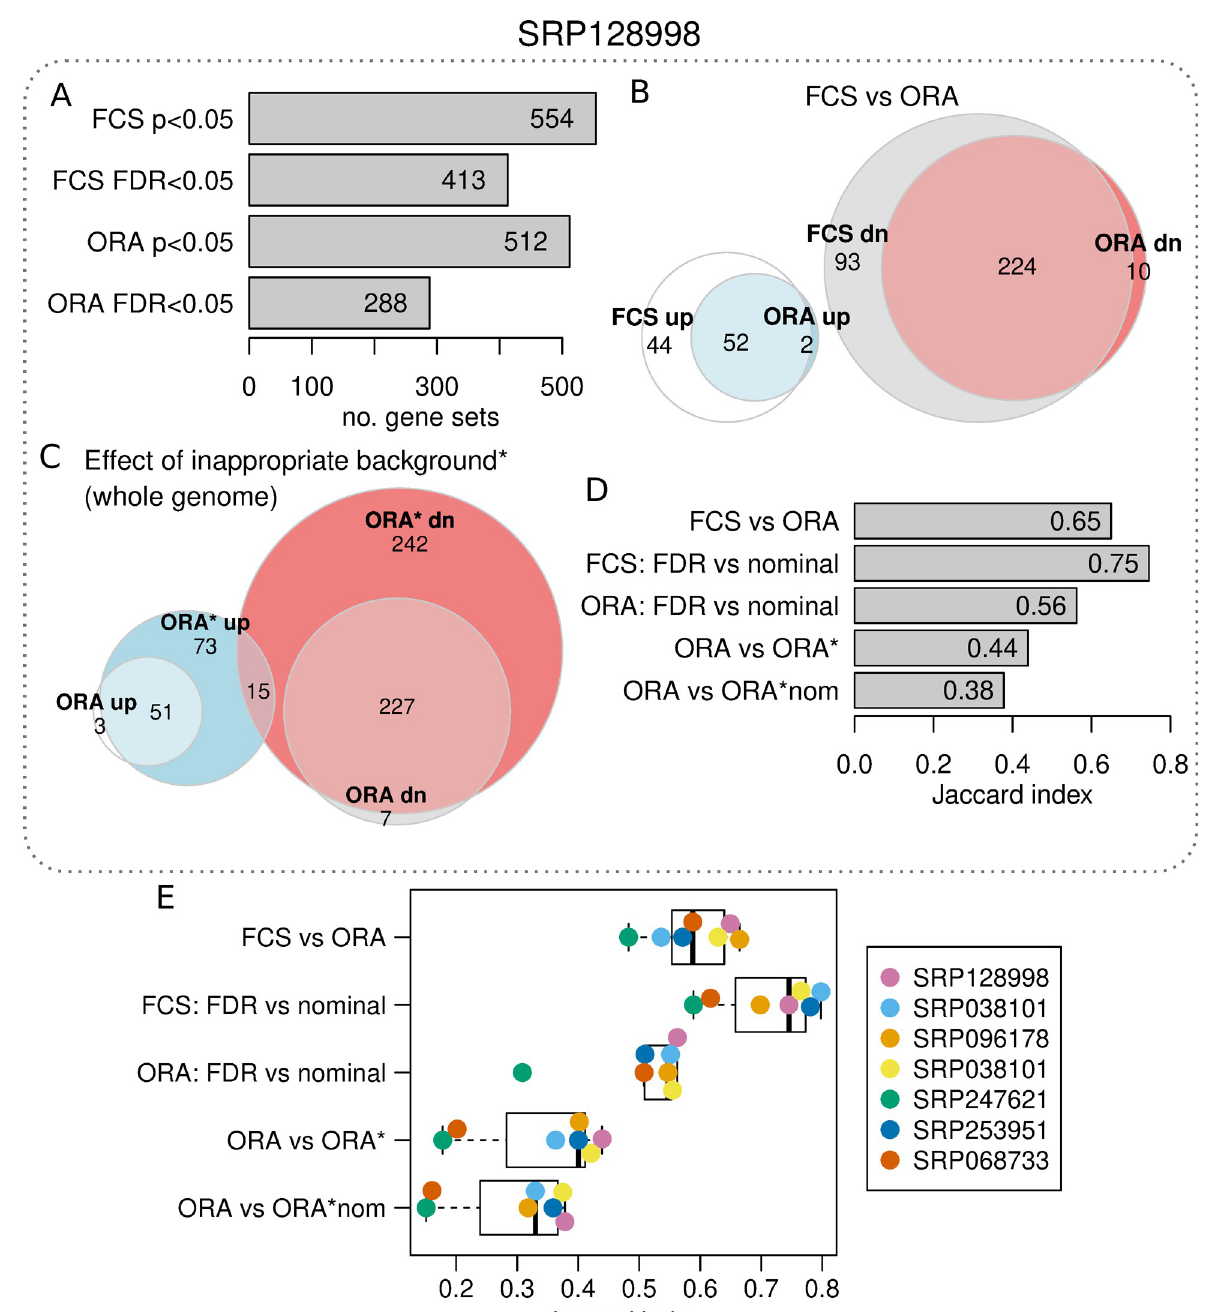
Fig 4. Example enrichment analysis misuse. (A) Number of differentially expressed gene sets for FCS and ORA methods using nominal p-value and FDR thresholds. (B) Euler diagram showing the overlap of differentially regulated gene sets with FCS and ORA methods (FDR < 0.05). (C) Euler diagram shows the overlap of ORA results when using recommended or whole genome background. Whole genome background analysis is indicated with a � . (D) Jaccard index values for enrichment analysis results when conducted in different ways. “FDR” refers to a significance threshold of FDR < 0.05. “Nominal” refers to a significance threshold of p < 0.05. “ORA � nom” refers to a whole genome background used in tandem with the p < 0.05 significance threshold. (E) Jaccard index values for enrichment analysis results when conducted in different ways for seven independent RNA-seq